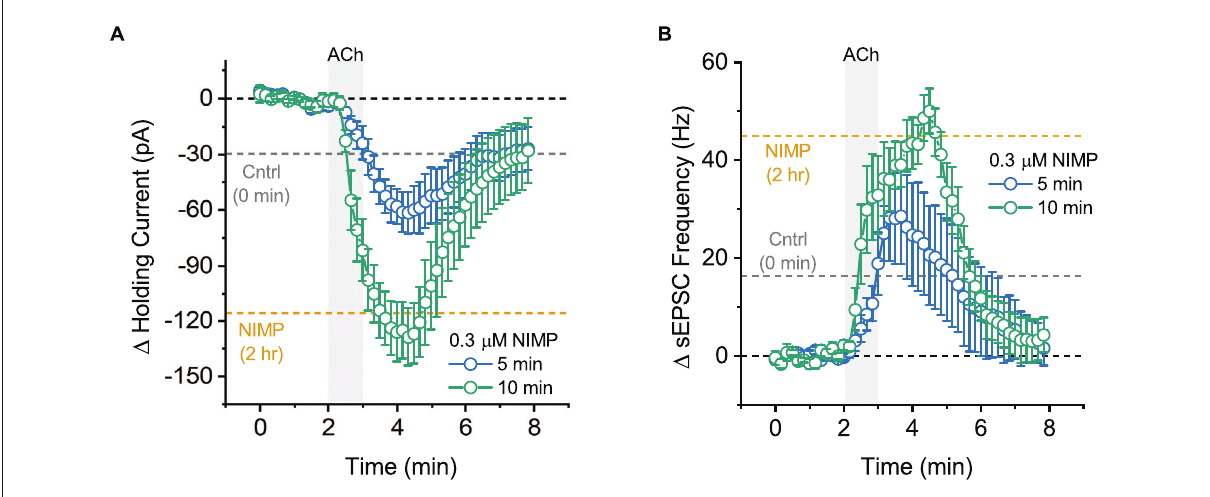
FIGURE5 Maximal effect of 0.3 µ M NIMP on ACh-evoked responses is apparent after 10 min, but not 5 min, of preincubation. (A) ACh-induced change in holding current over time as produced by acute bath application of ACh in BLA pyramidal neurons preincubated in 0.3 µ M NIMP for 5 vs. 10 min (open blue vs. open green circles respectively). (B) ACh-induced change in sEPSC frequency produced by acute bath application of ACh in BLA pyramidal neurons preincubated in 0.3 µ M NIMP for 5 vs. 10 min (open blue vs. open green circles respectively). In both panels, the dashed gray and orange lines highlight the mean ACh-induced response as observed at 3–4 min in BLA pyramidal neurons from control and 0.3 µ M NIMP datasets as illustrated in Figures 1 , 2B . Dashed black lines highlight 0 pA or 0 Hz. Error bars represent the